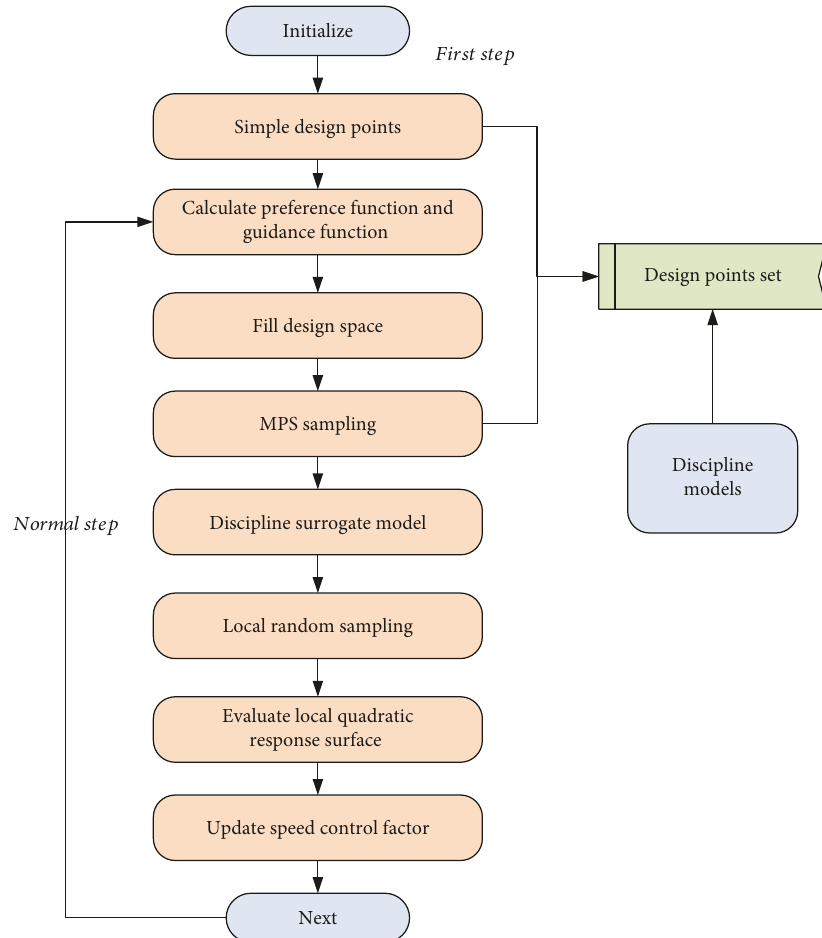
Figure 3: Flowchart of the adaptive discipline surrogate